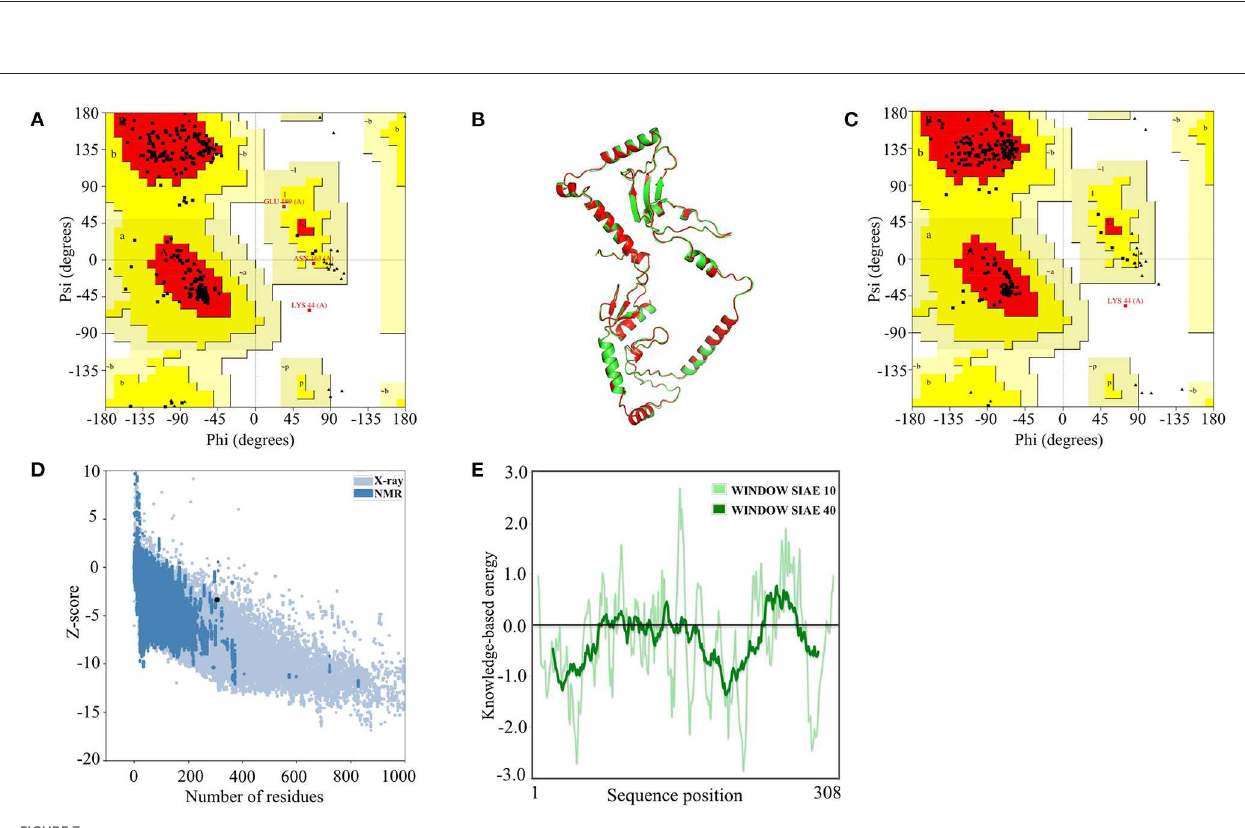
FIGURE7 Validation of tertiary structure of epitope vaccine. (A) Ramachandran plots to validate the tertiary structure; (B) For comparison of tertiary protein structure, the crude model and refined model are green and red, respectively; (C) The Ramachandran mapping validates the optimized tertiary structure; (D) The Z fraction of the ProSA SEB diagram of the refined model is − 3.34; (E) The quality of the local model is shown by plotting the energy as a function of the position of the amino acid